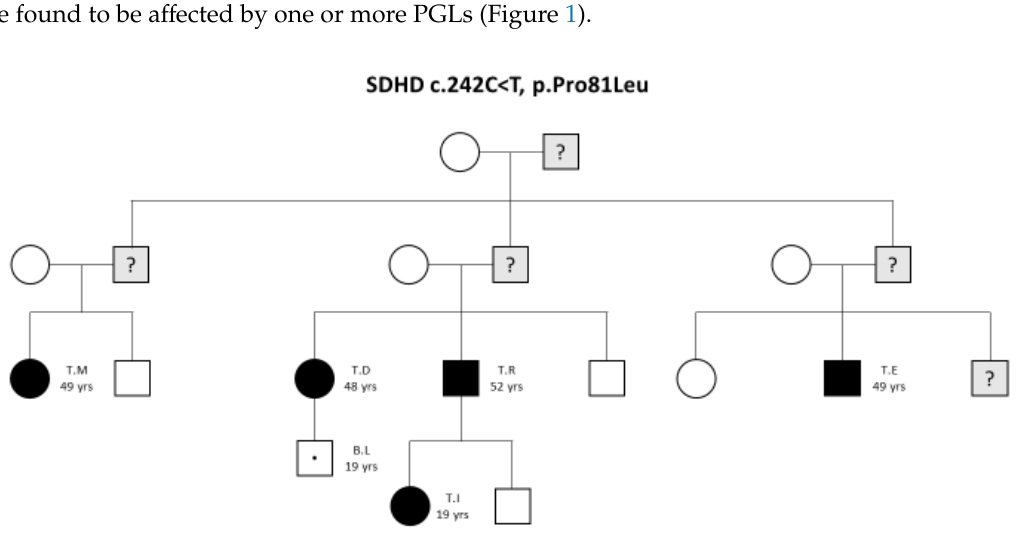
Figure 1. Family tree. Abbreviation: SDHD, succinate dehydrogenase complex subunit D.